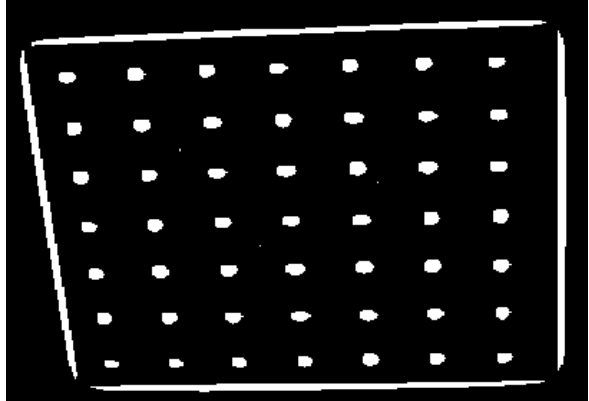
Figure 4. Segmented image of the calibration table generated from a TIR image. Calibration marks and border are clearly visible.